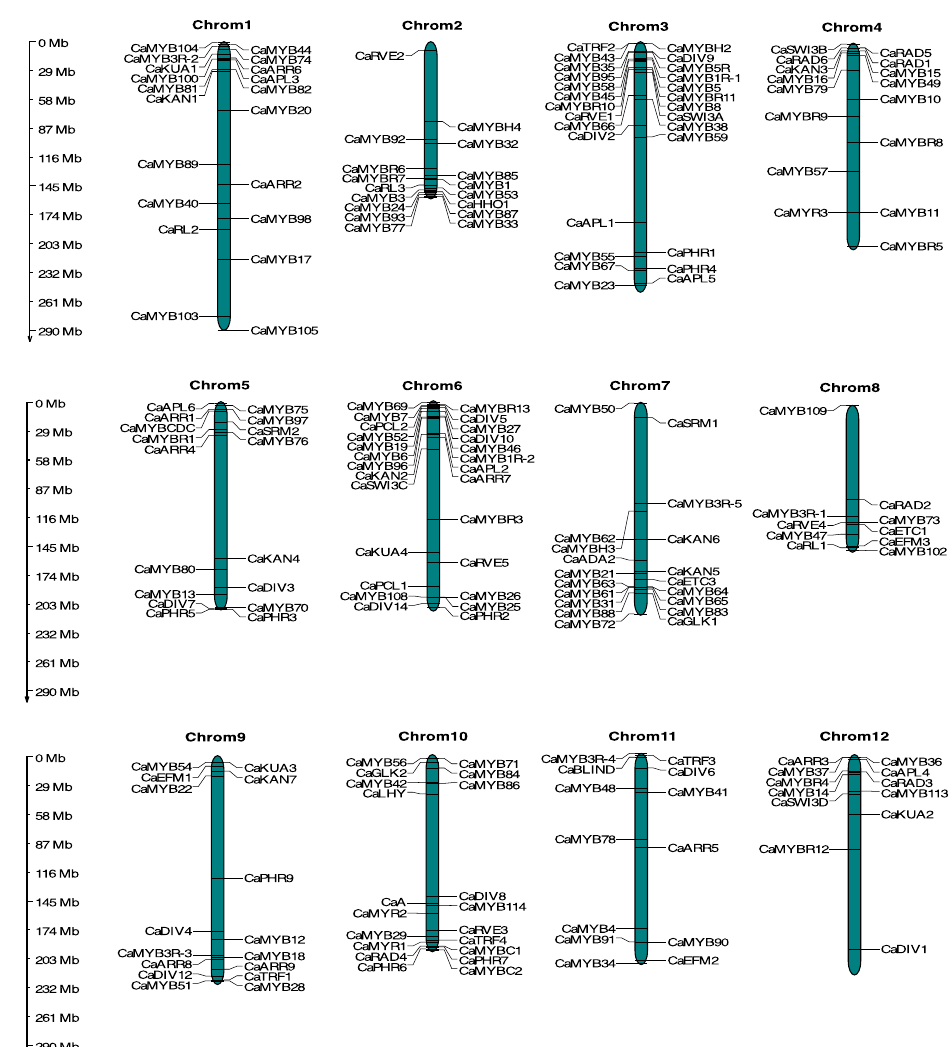
Figure 2. Chromosomal distribution of CaMYB genes. The chromosomal position was mapped according to the Capsicum annuum genome. Only 213 MYBs were mapped to the 12 chromosomes of C. annuum . The chromosome number is indicated at the top of each chromosome. The scale on the left is in megabases (Mb).